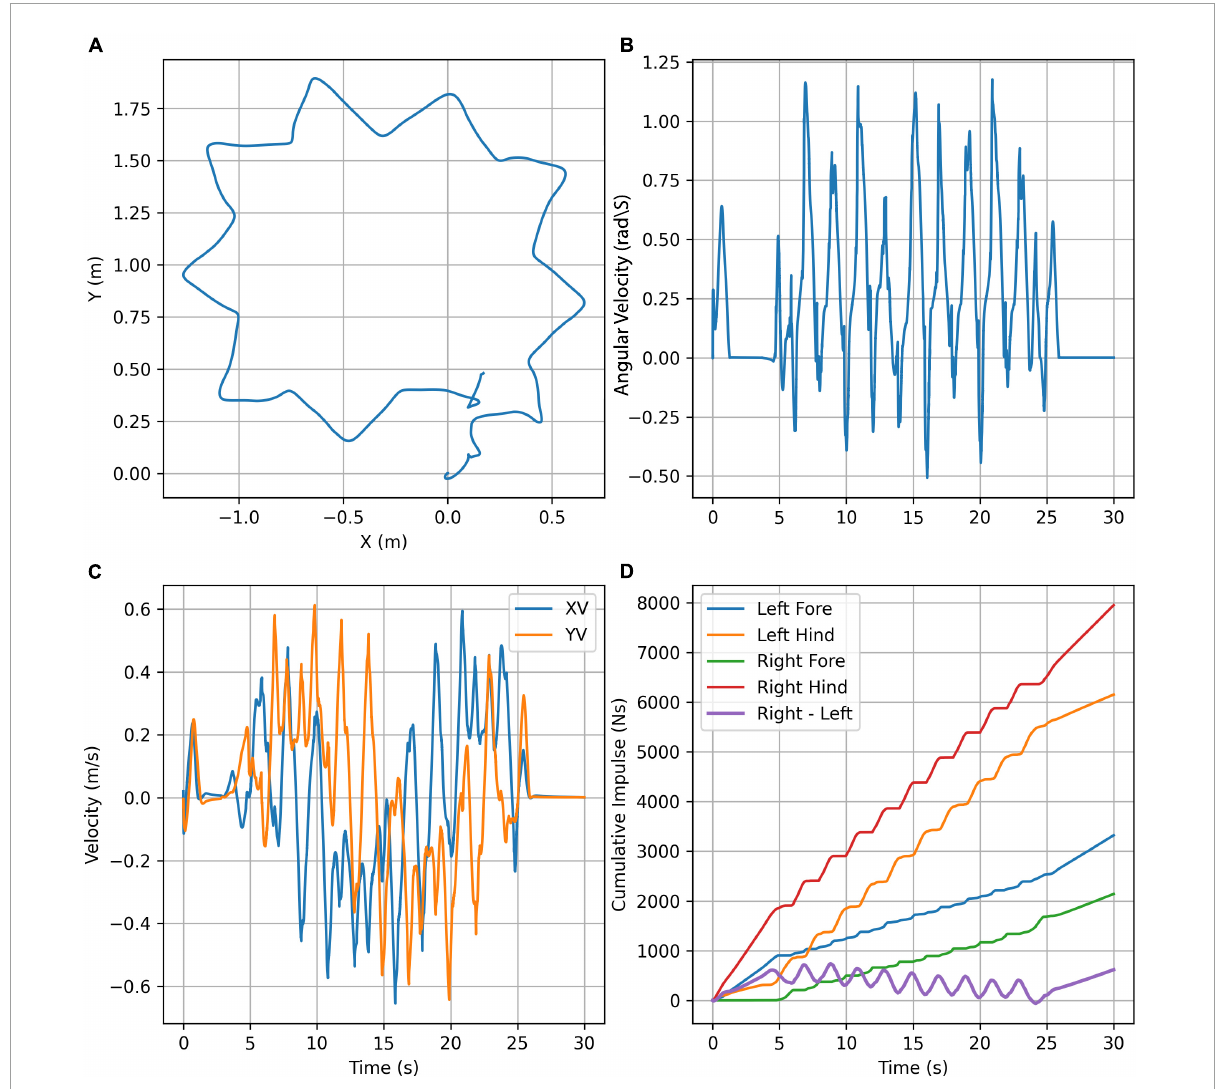
FIGURE5 Turning simulation plots. (A) Trajectory plot showing the top view of the path taken by the center of mass of the chimpanzee’s torso. (B) Angular velocity of the torso about the Z (vertical) axis. (C) Velocity plot showing the X (forward) velocity and Y (lateral) velocity of the center of mass of the chimpanzee’s torso. (D) The vertical cumulative impulse at the contact points and the difference between the totals on the right-and left-hand